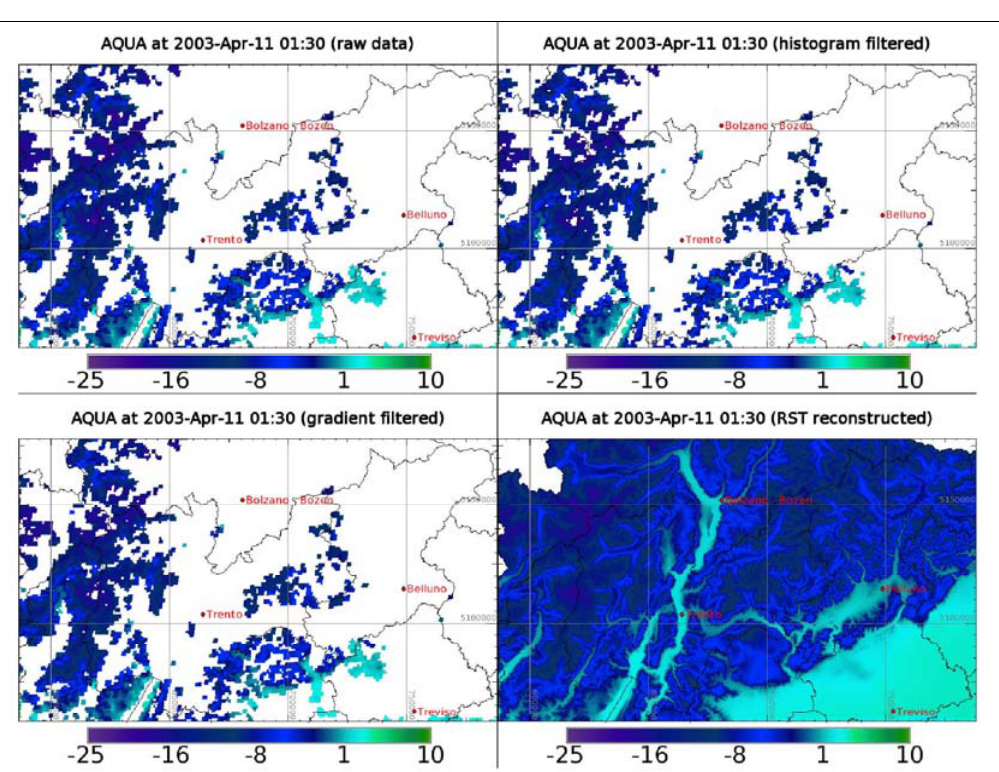
Figure 4 . Spring MODIS LST night map reprocessing (11 April 2003 at 01:30 hs, all maps in UTM32/WGS84 metric grid, map scale 1:2,600,000): Raw LST map (upper left), map outlier filtered via histogram (upper right), outlier filtered via gradient (central left), volumetric splines reconstructed (RST, central right), differences map between the raw and RST maps (lower left), scatterplots of raw (black), histogram & gradient filtered (yellow) and RST (green) maps including linear regression gradients (lower right). For explanations, see